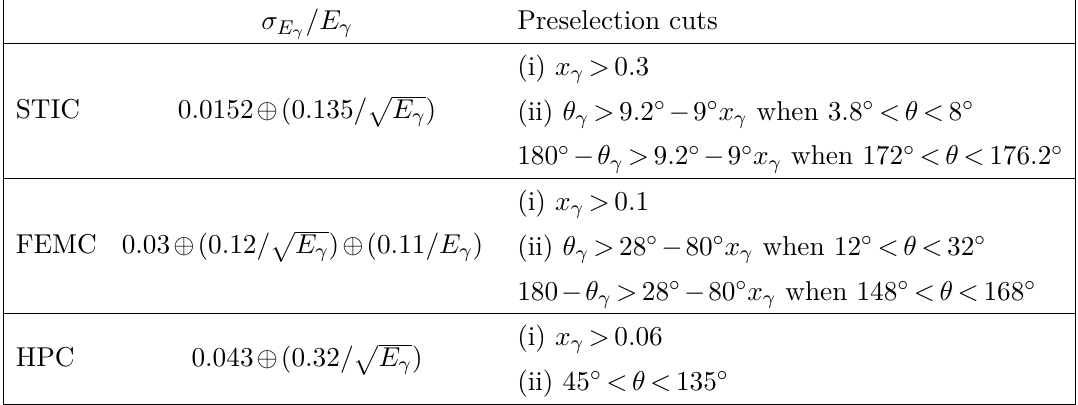
Table 1 . Preselection cuts and energy resolution for the three sub-detectors in the electromag- netic calorimeters in DELPHI: STIC, FEMC, and HPC [71]. Here E x γ = E γ /E beam